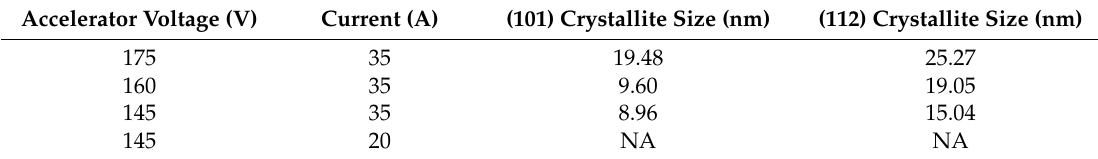
Table 2. XRD analysis providing crystallite size trend data based from the Scherrer equation.